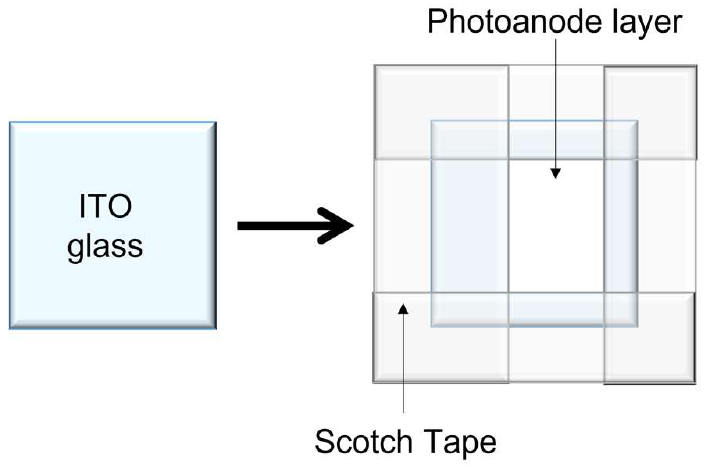
Figure 2. Photoanode semiconductor material deposition using the doctor blade method.